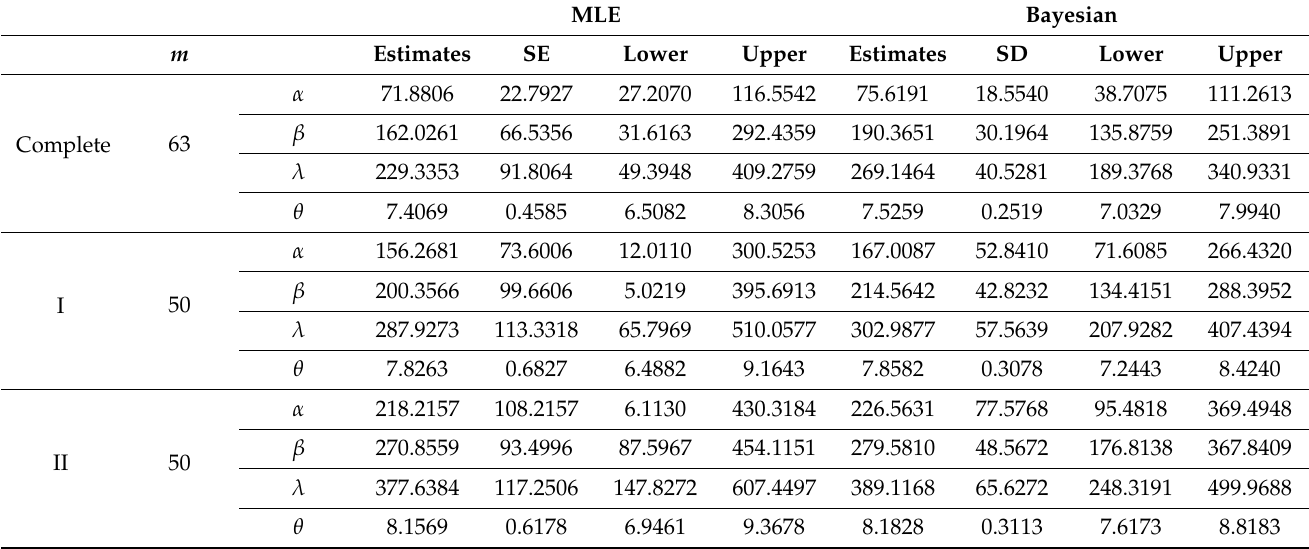
Table 9. The MLE and its SE and Bayesian and its SD with confidence intervals.